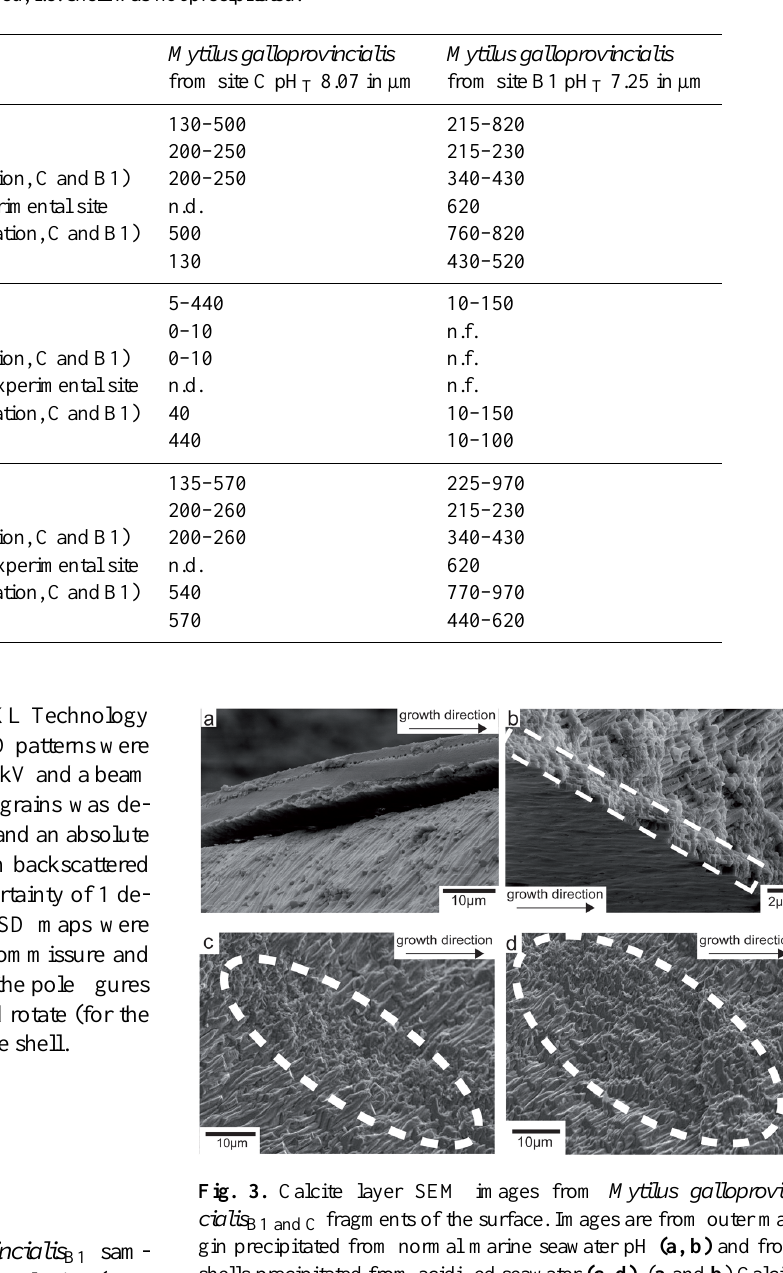
Table 2. Thickness characteristics of different shell layers of M. galloprovincialis B1 and C in µm. Shell thickness was measured before and after transplantation. N.d.=no data; n.f.=not formed, i.e. shell was not precipitated.